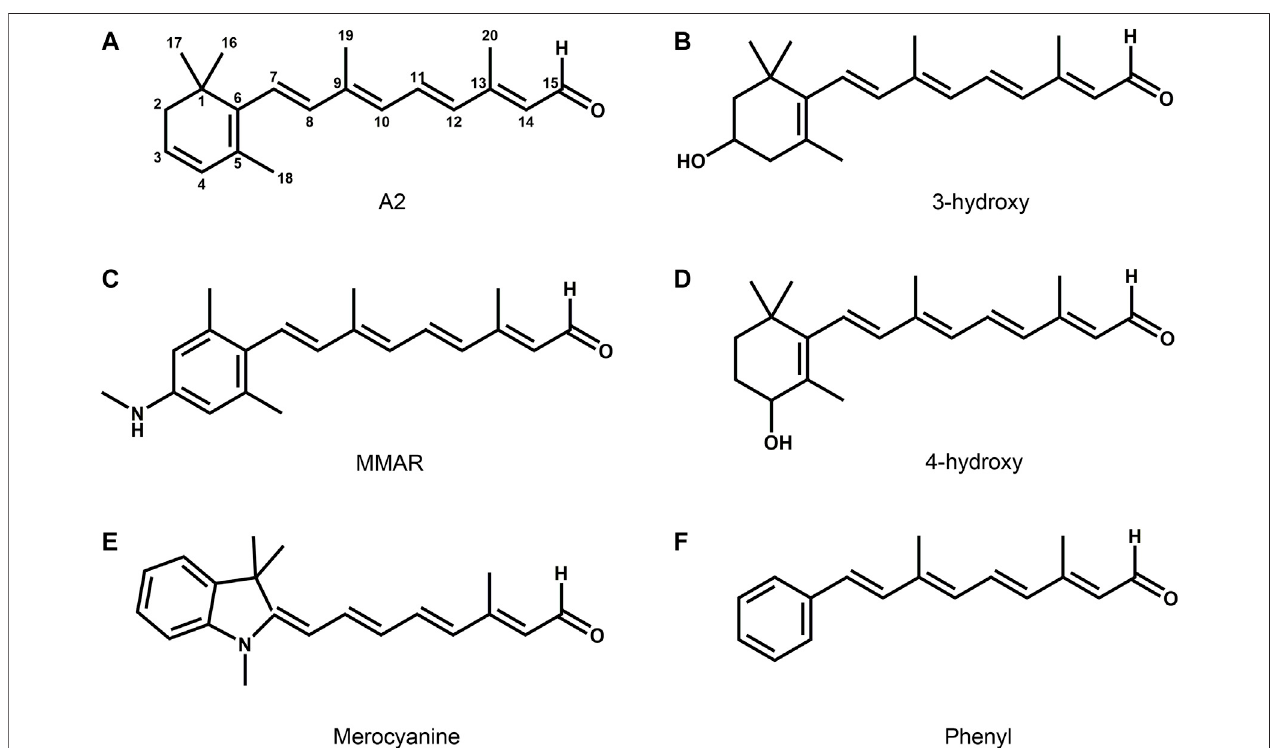
FIGURE5| Someuncommonretinalanalogsoccurringasnaturalchromophoresorinengineeredpigmentanalogs.3,4-didehydroretinal(retinalA2, (A) )red-shifts therhodopsinspectrumrelativetoA1,andismostlyfoundin fi shandamphibianvisualpigments.3-hydroxy- (B) and4-hydroxy- (D) retinalA1induceablue-shiftrelative to A1 and are found in the visual pigments of insects and deep-sea shrimps, respectively. Phenylretinal (F) , MMAR (C) and the merocyanine derivative (E) are synthetic analogs,that,respectively,induceablue-shift (F) andthelargestred-shifts,observedsofar( (C,E) ;seetext).Alltheseanalogsbindtothelysineresidueinthenative opsin binding pocket with a protonated Schiff